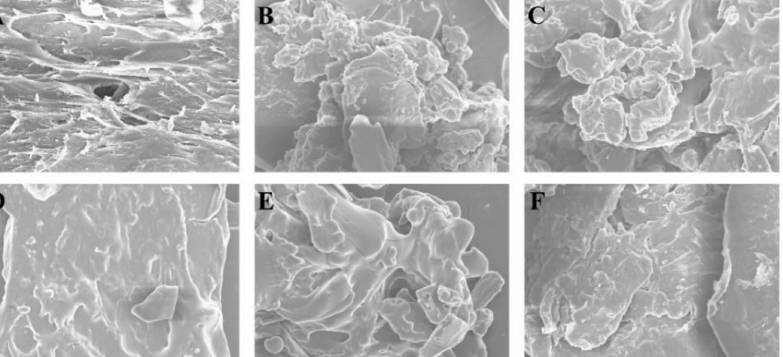
Figure 8. The microstructures of the maltitol, erythritol, gelatin, and low acyl gellan gel with different maltitol and erythritol content. The magnifications of each group images are set as 1000 × . ( A ) control group. ( B ) Contain with 1.65 wt% Mal. ( C ) Contain with 3.3 wt% Mal. ( D ) Contain with 1.65 wt% Mal and 1.65 wt% Ery. ( E ) Contain with 2 wt% Mal and 1 wt% Ery. ( F ) Contain with 1 wt% Mal and 2 wt%